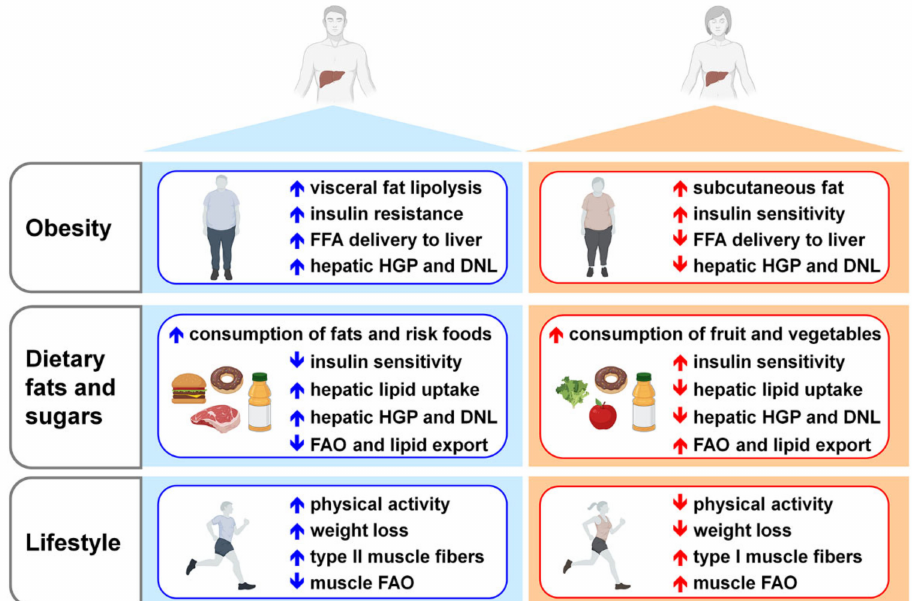
Figure 4. Main risk factors for NAFLD development in men and women. For both sexes, obesity, unbalanced dietary regimens and reduced physical activity represent risk factors for NAFLD devel- opment and progression. Arrows represent the relative regulation between males (blue) and females (red). Compared to men, obese pre-menopausal women display more subcutaneous than visceral fat and higher insulin sensitivity, leading to reduced adipose tissue lipolysis and FFA delivery to liver; women show limited HGP and DNL. Under an excess of dietary sugars and fats, with respect to men, women have higher insulin sensitivity, inhibit hepatic lipid uptake, HGP and DNL, and promote FAO and lipid export. Although generally women have a lower physical activity than men, when exercised, oxidize more fats due to the increased type I muscle fibers. Abbreviations: DNL, de novo lipogenesis; FAO, fatty acids oxidation; FFA, free fatty acids; HGP, hepatic glucose